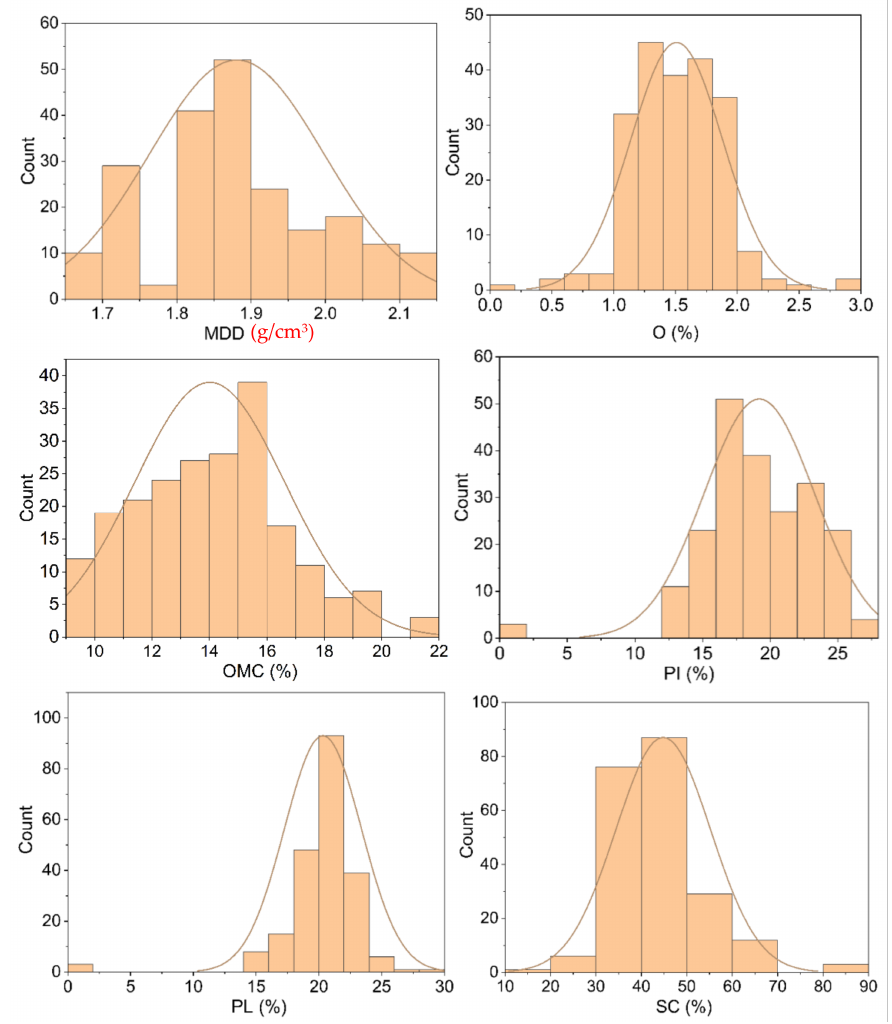
Figure 1. Statistical analysis distribution of the input parameters in this study.